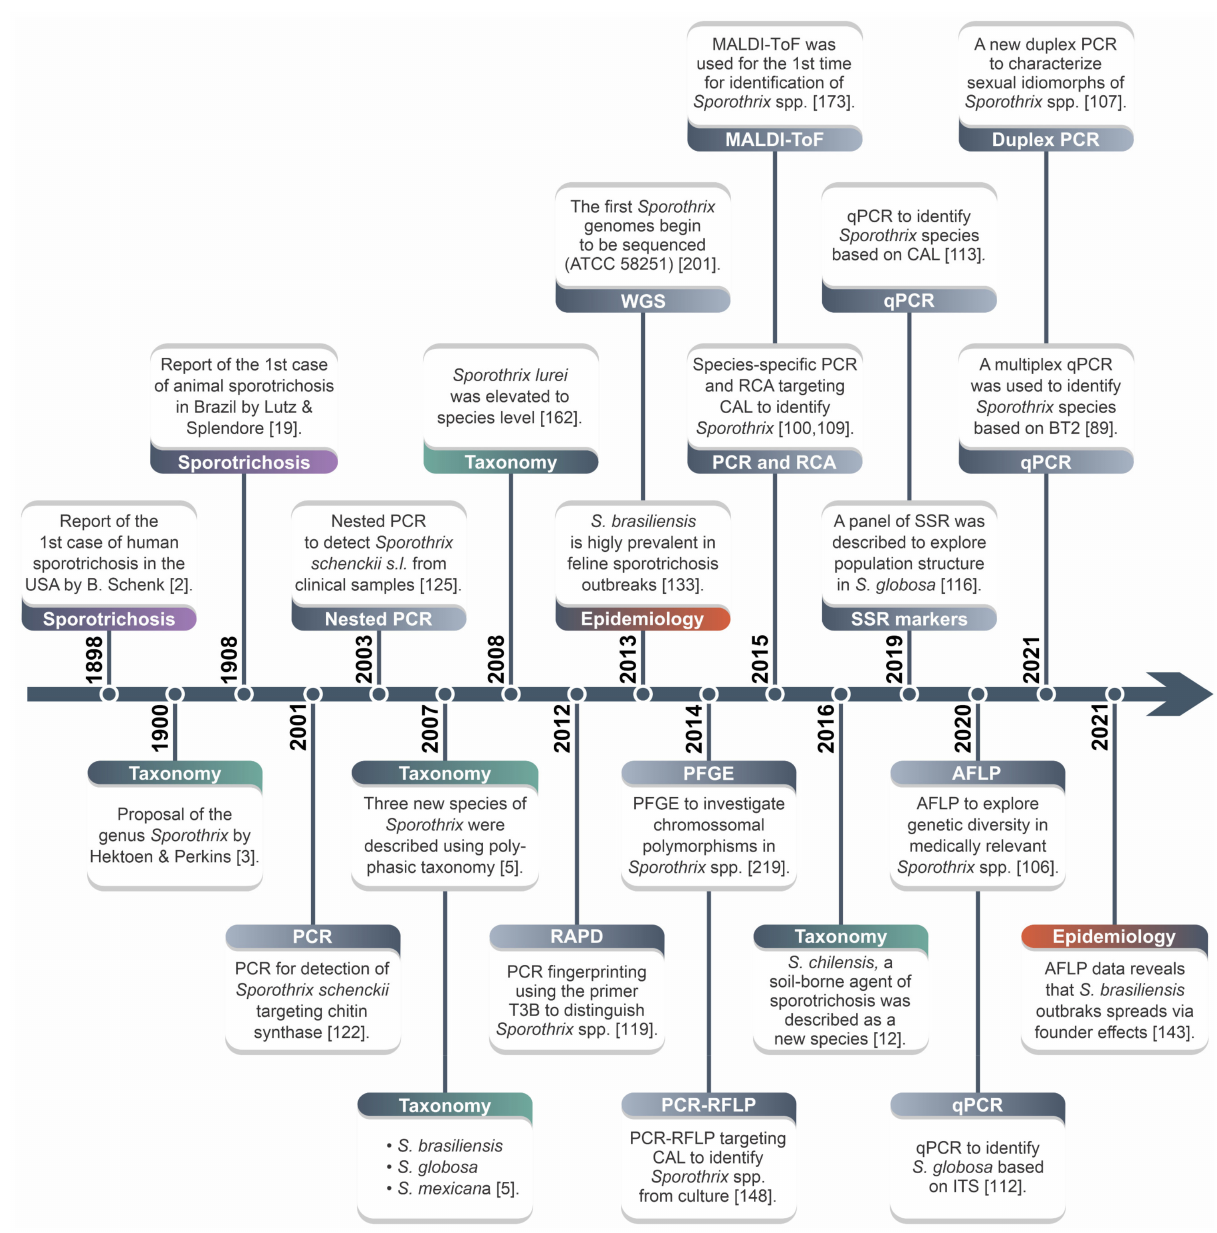
Figure 9. Major developments in the diagnosis/genotyping of the Sporothrix species. MLSA: multi- locus sequence analysis; RAPD: randomly amplified polymorphic DNA; CAL: calmodulin; PCR-RFLP: polymerase chain reaction-restriction fragment length polymorphism; WGS: whole-genome sequencing; PFGE: pulsed-field gel electrophoresis; RCA: rolling circle amplification; MALDI-ToF: matrix-assisted laser desorption ionization time-of-flight mass spectrometry; SSR: simple sequence repeat; qPCR: quantitative polymerase chain reaction; AFLP: amplified fragment length